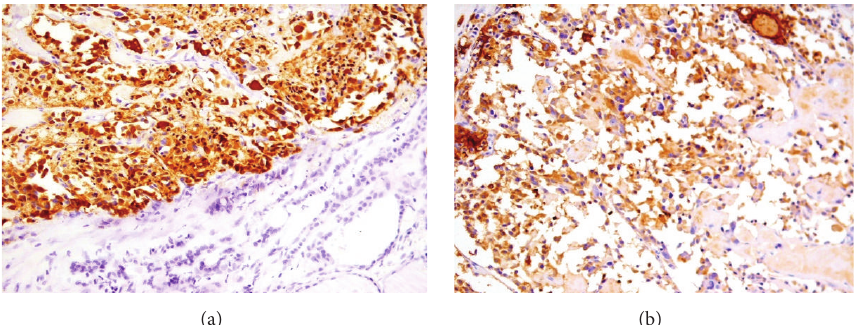
Figure 2: On immunohistochemistry tumor cells were positive for calcitonin ((a) × 200) and CEA ((b) ×